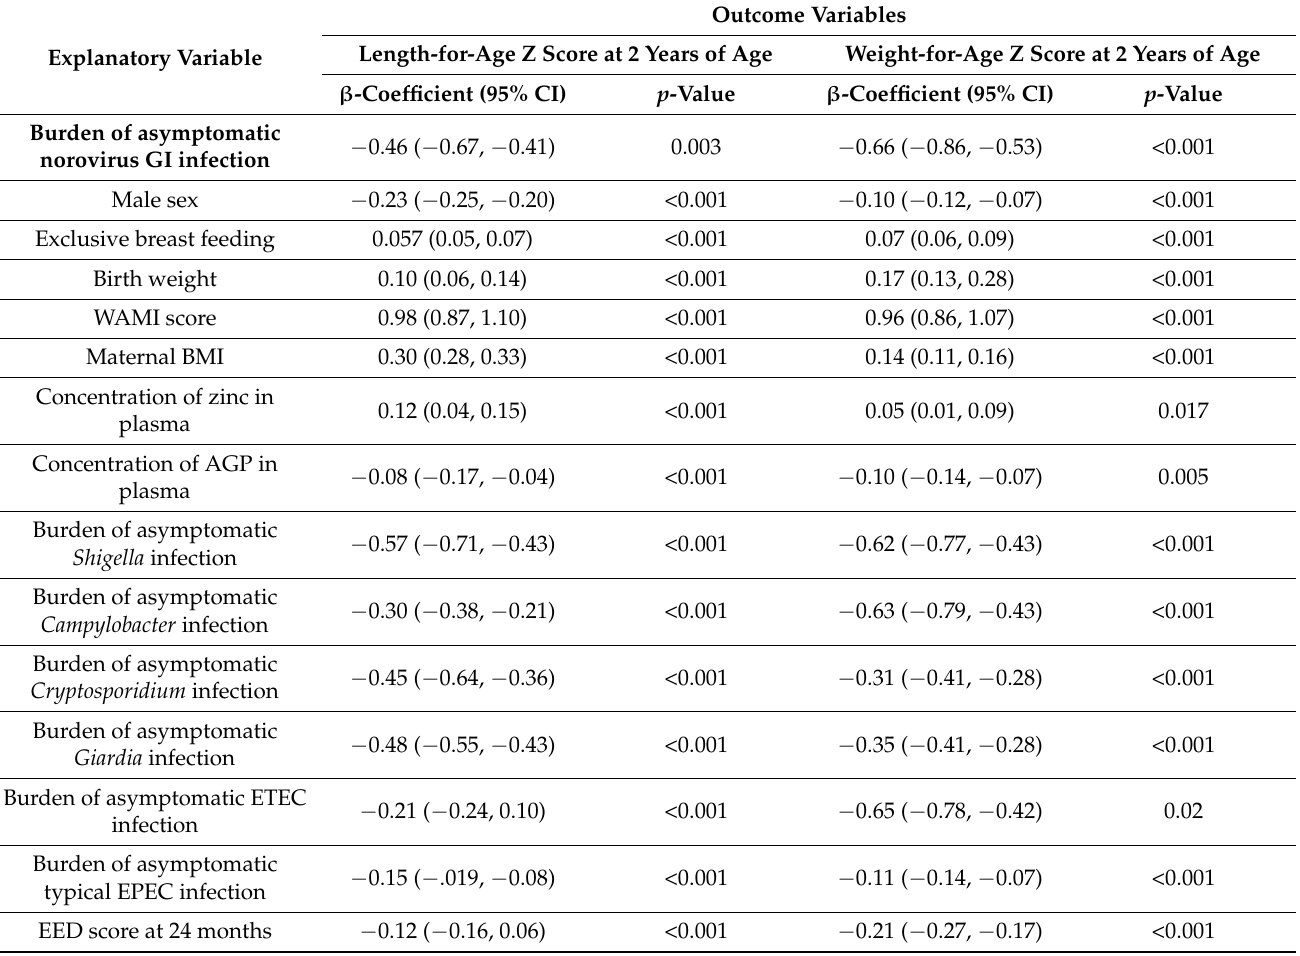
Table 4. Association of burden of asymptomatic norovirus GI infections with linear growth and ponderal growth at 2 years of